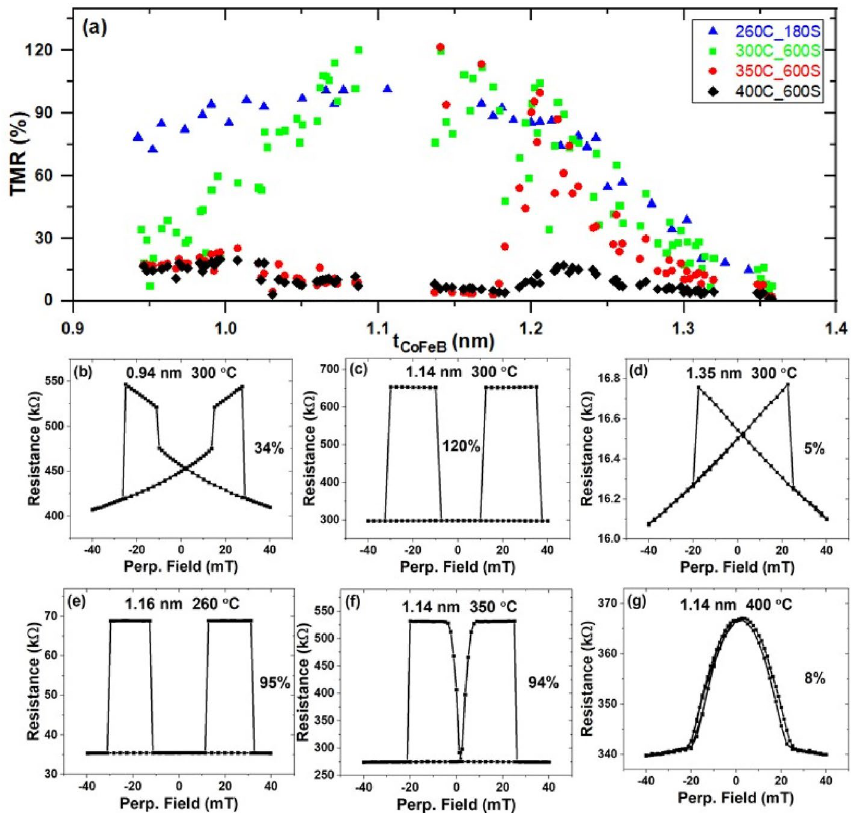
Figure 2. ( a ) Evolution of TMR in Nb-pMTJs with different top CoFeB layer thicknesses after annealing under several different conditions. The samples were successively annealed at 260 °C for 3 min, 300 °C for 10 min, 350 °C for 10 min, and 400 °C for 10 min. ( b – d ) TMR hysteresis curves with ( b ) 0.94 nm, ( c ) 1.14 nm, ( d ) 1.35 nm top CoFeB thickness after the 300 °C annealing for 10 min. ( e – g ) TMR curves under different annealing conditions with similar top CoFeB thicknesses (around 1.14